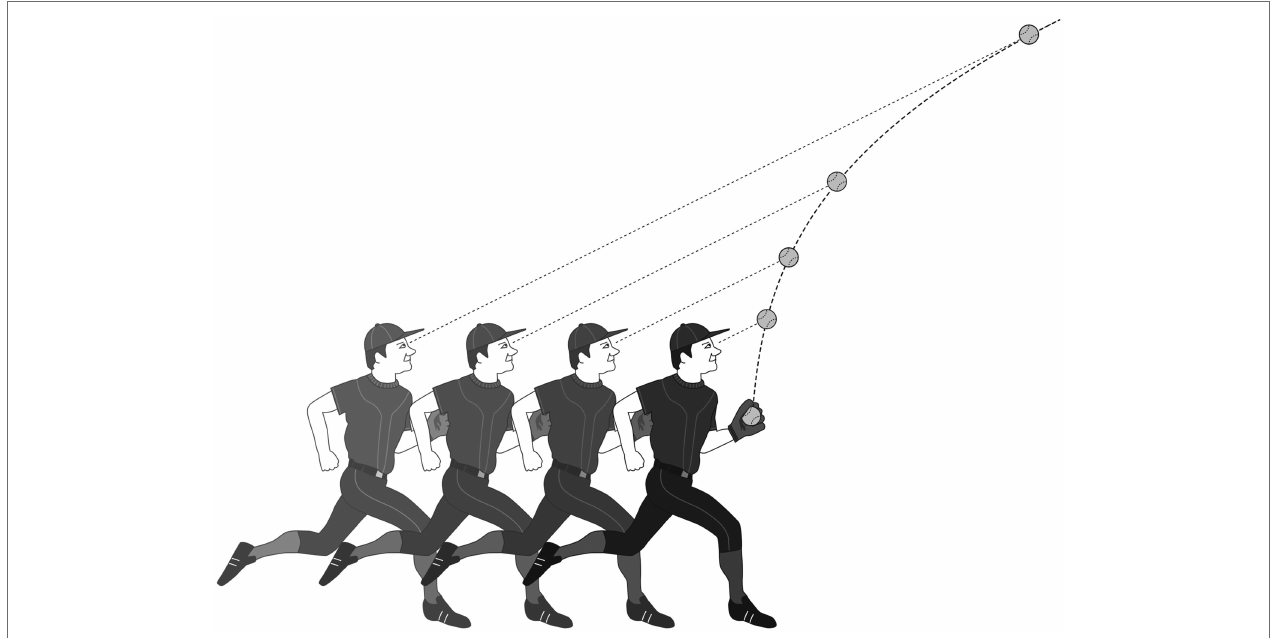
FIGURE 2 | Gaze heuristic. The player adjusts the running speed so that the angle of gaze remains constant. The angle of gaze is the angle between the line from eye to ball and the ground. Shown is the player’s position relative to the ball for four points in time.